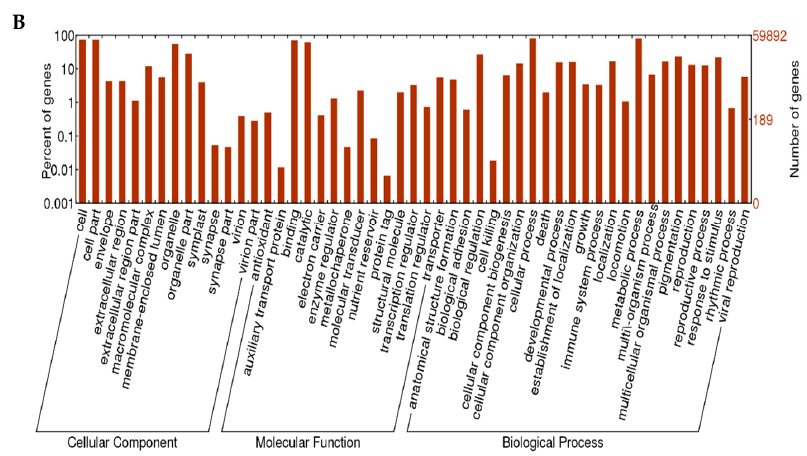
Figure 4. Gene Ontology (GO) annotation of the L. radiata unigenes. ( A ) replicate 1; ( B ) replicate 2.